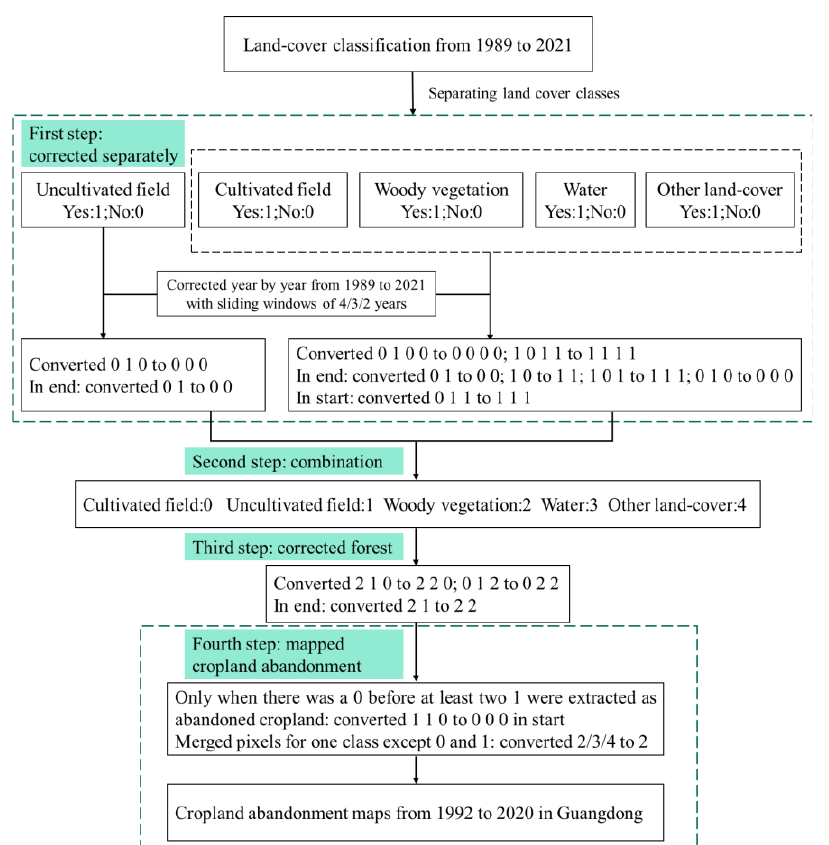
Figure 9. Time-series land covers correcting and cropland abandonment mapping steps for multi-year periods.